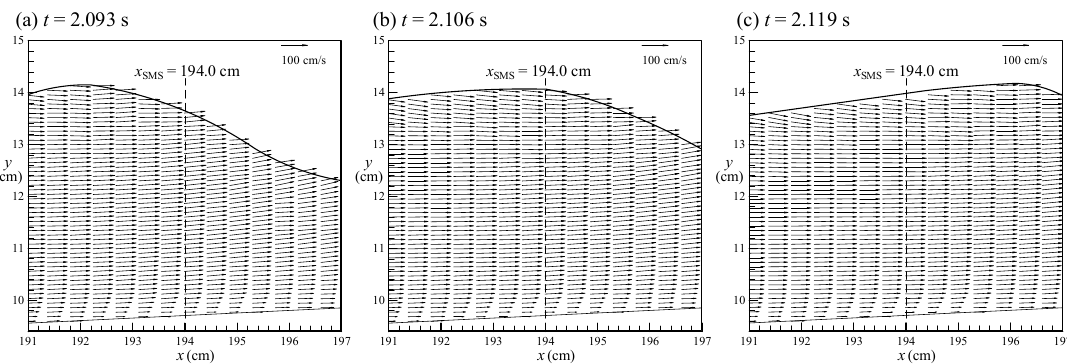
Figure 6. Ensemble-averaged velocity fields at ( a ) t = 2.093 s; ( b ) t = 2.106 s; ( c ) t = 2.119 s during run-up motion of generated bore.